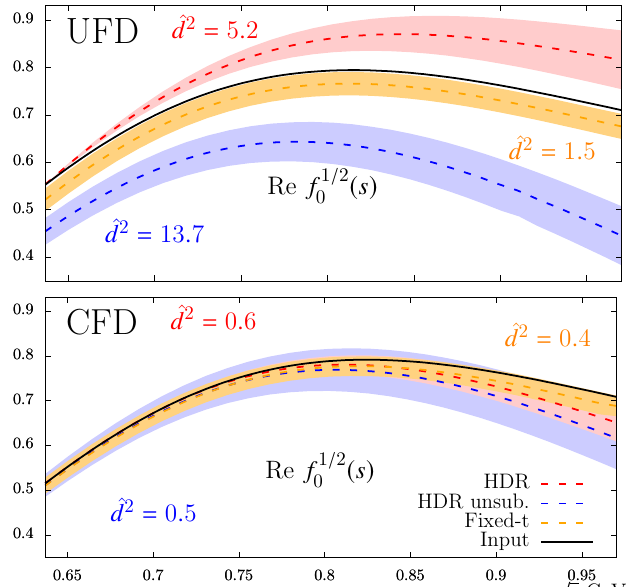
Figure 7. Top: We show how the outputs of three di ff erent Roy-like dispersion relations, obtained from hyperbolic dispersion relations with one subtraction (HDR) or unsubtracted (HDR unsub.) or from fixed- t dispersion relations, are inconsistent for the π K → π K scalar-isospin 1 / 2 partial wave, when using the same Unconstrained Fits to Data (UFD) as input in the integrals. Bottom: Good agreement within uncertainties is obtained from Constrained Data Fits (CFD), which do not change much the physical description of data but the unphysical region of the crossed ππ → K ¯ K channel. Figures taken from [17].